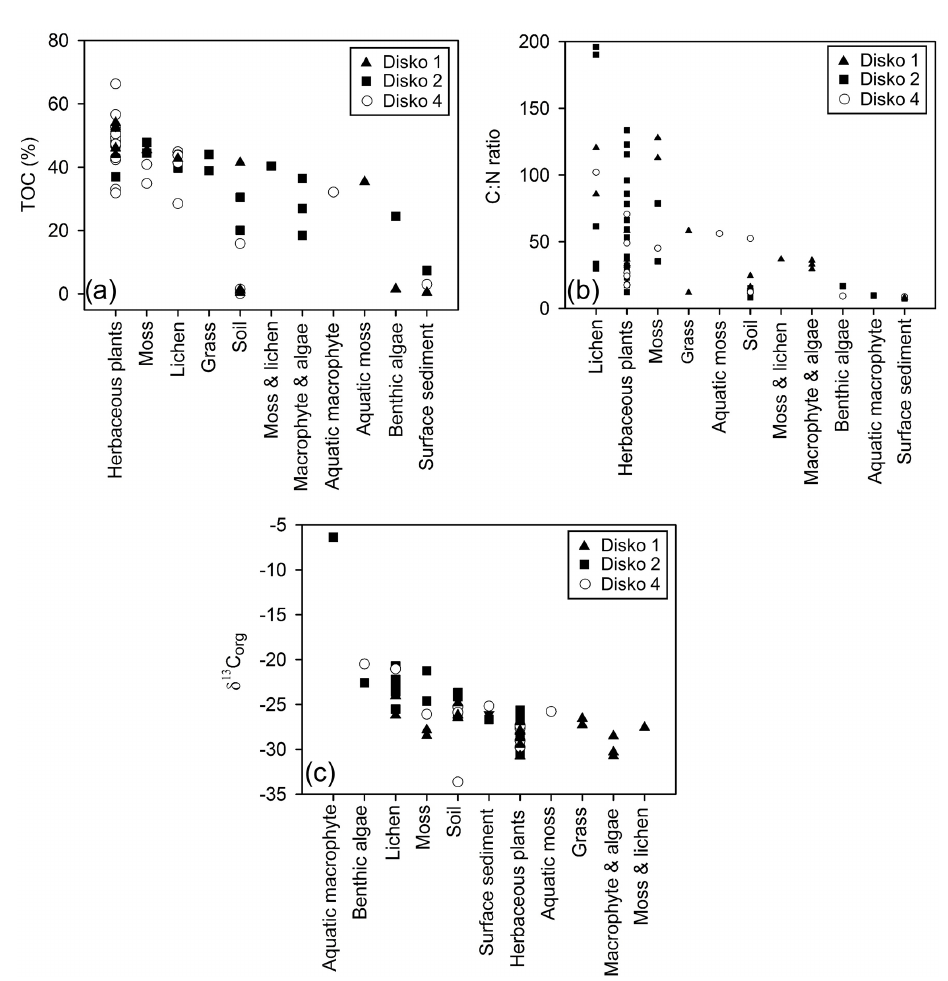
for woody terrestrial plants. The ratio of brassicasterol /